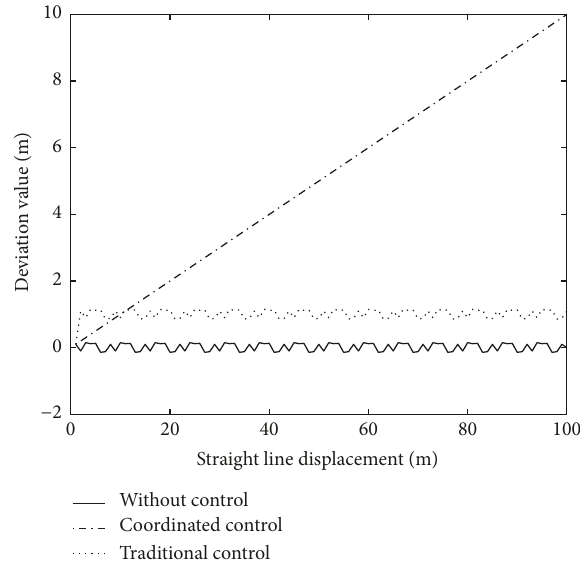
Figure 3: Simulation results of the straight line drive coordinated control on different adhesive coefficients